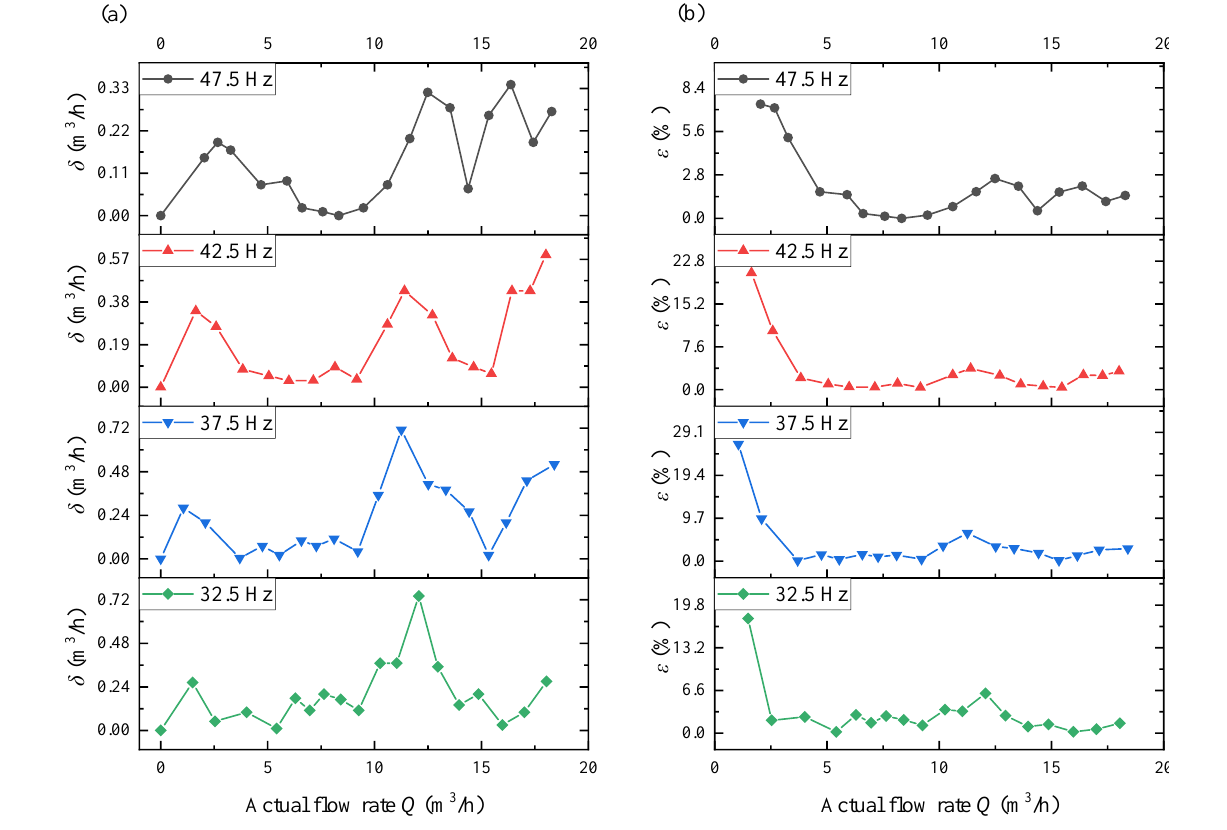
Figure 17. Errors of the estimated flow rate: ( a ) absolute errors and ( b ) relative errors.